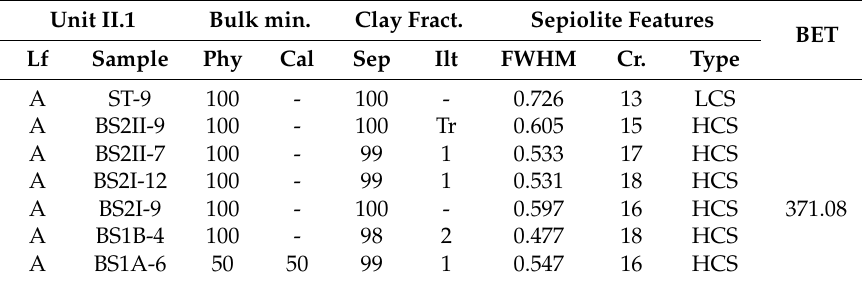
Table 3. Bulk (% w / w ) and clay mineralogy (% w / w ) of Unit II.1 lithofacies. Sepiolite FWHM values (°2Θ), crystallite sizes (Cr.) (nm) and “crystallinity” are also shown. Abbreviations are according to Whitney and Evans [27], except phyllosilicates (Phy), trace minerals (Tr) and not detected (-): Qz, quartz; Fsp, feldspar; Cal, calcite; Dol, dolomite; Sme, smectite; Sep, sepiolite; Ilt, illite; Kln, kaolinite. The order inside each lithofacies group of samples is related with the geographical location, from north to south, of lithological sections. Unit II.1 Bulk min. Clay Fract. Sepiolite Features BET Lf